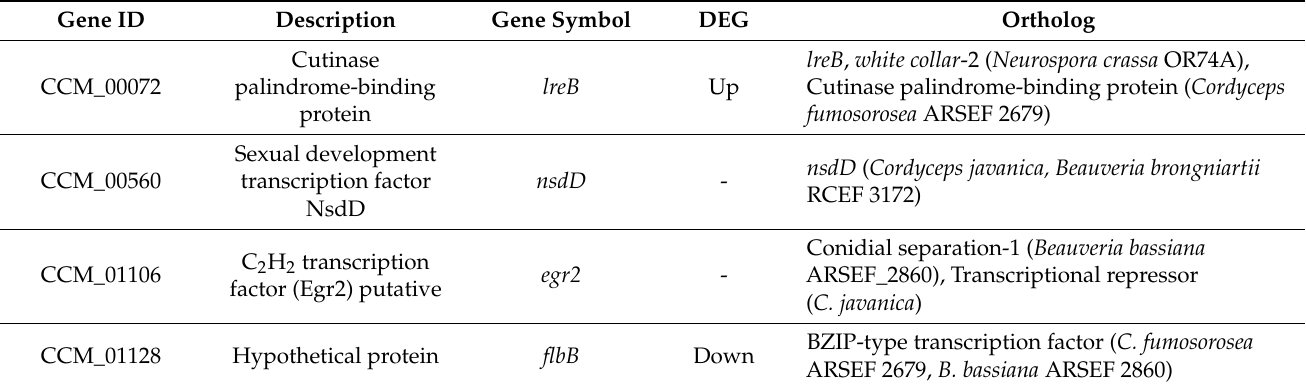
and their orthologs. The homology analysis results are available in Supplementary File